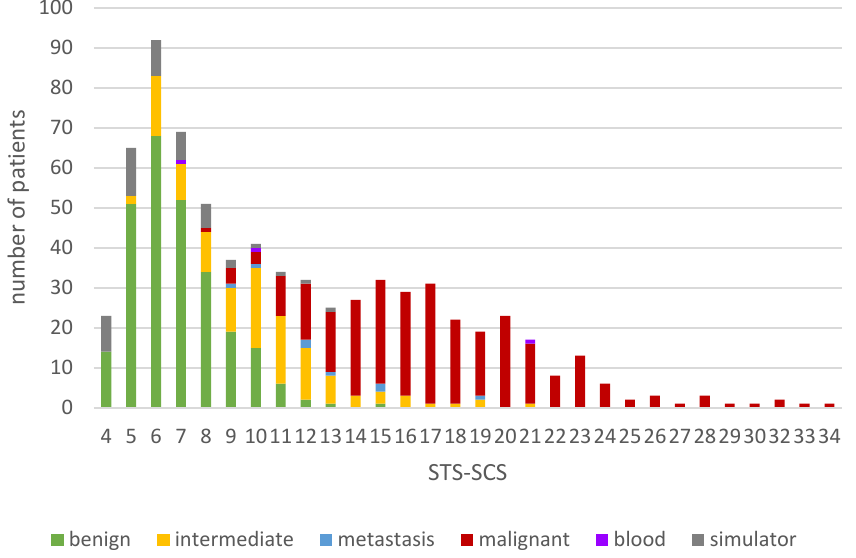
Figure 3. Distribution of the totals of the soft tissue tumor surgery complexity score (STS-SCS) in the sampling group.